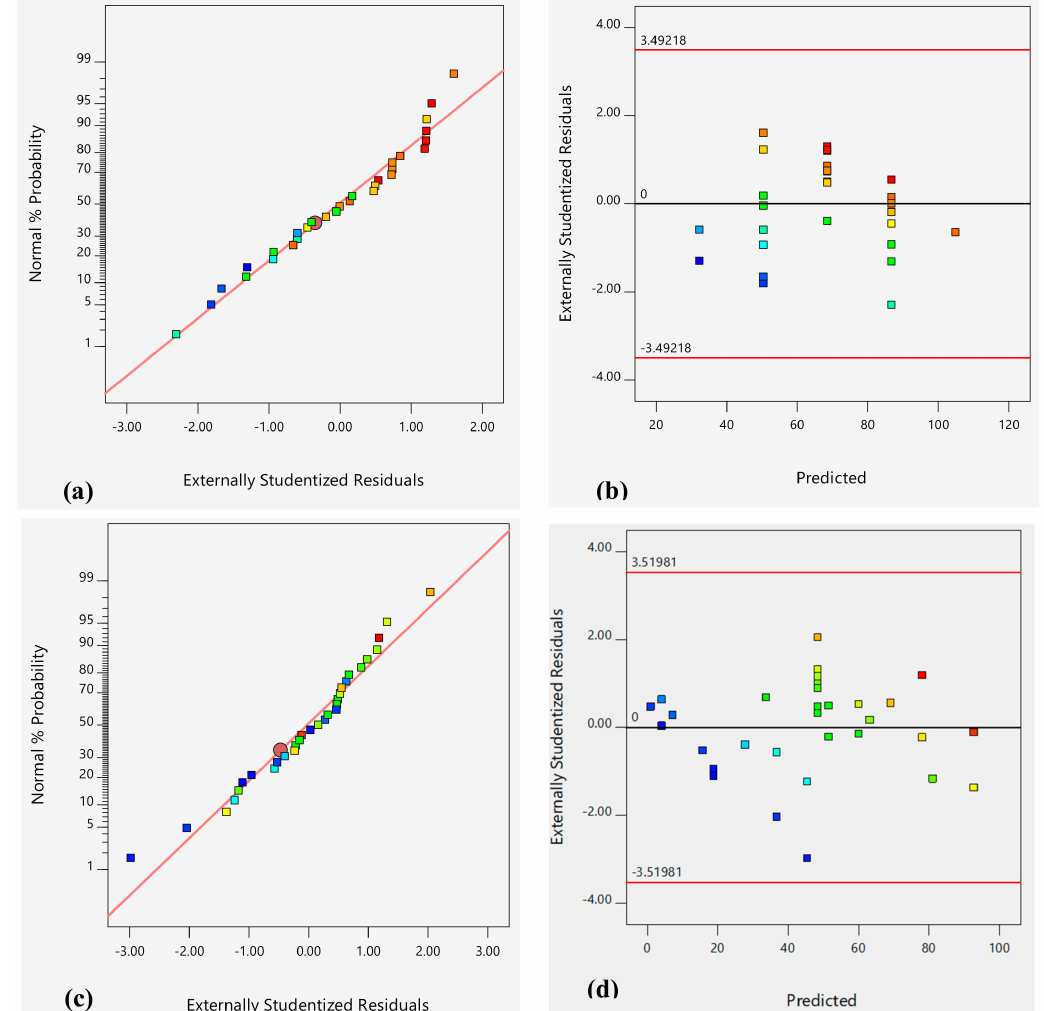
Figure 7. Model adequacy tests for R MO response: Normal probability of the externally studentized residuals ( a ), Predicted versus externally studentized residuals ( b ). Model adequacy tests for R MB response: Normal probability of the externally studentized residuals ( c ), Predicted versus externally studentized residuals ( d